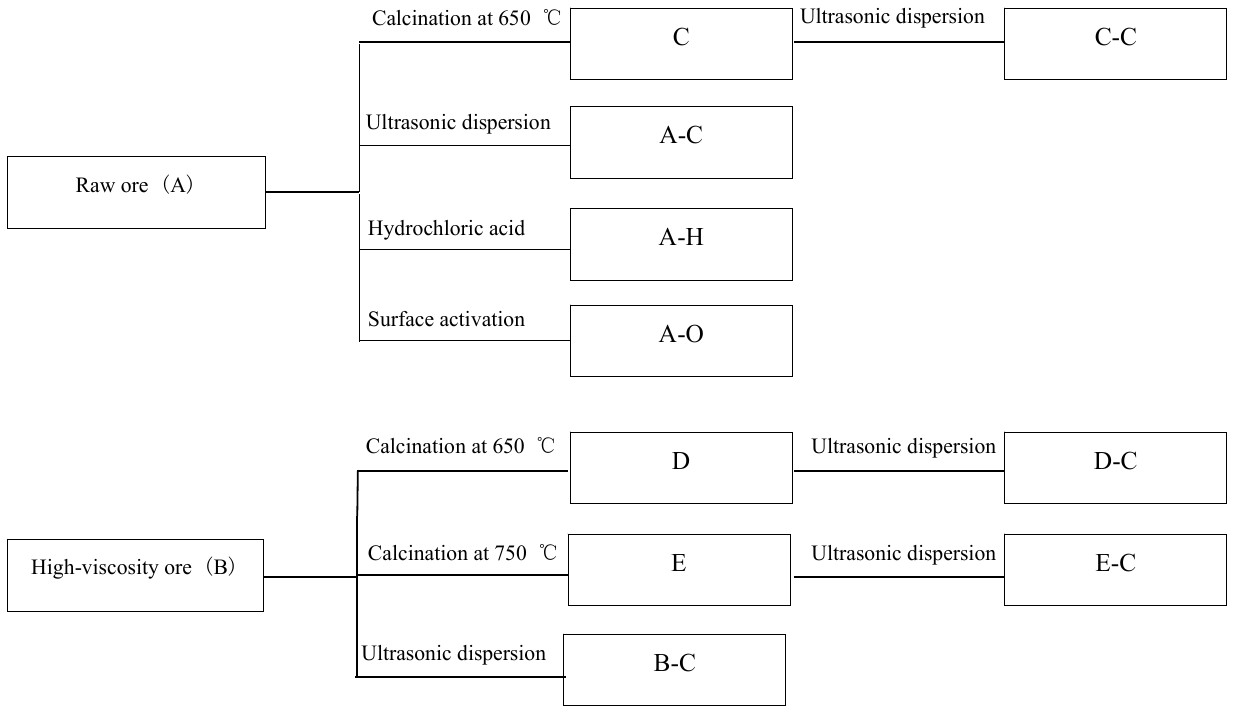
Figure 1. Different activation methods and sample numbers of NAC.